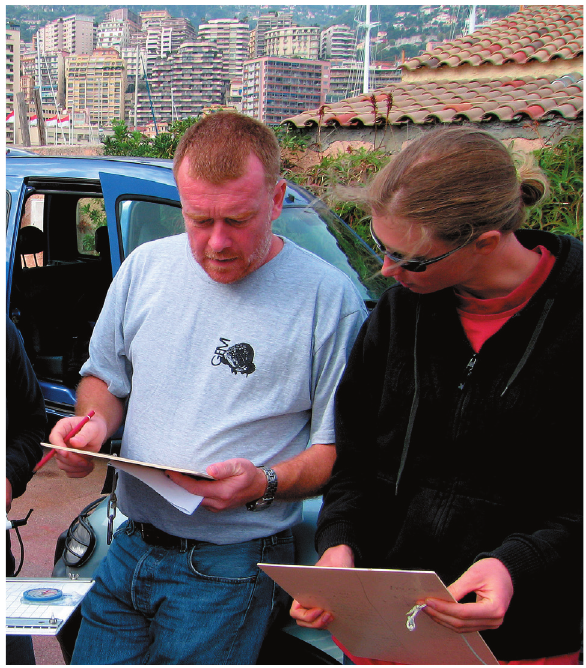
Fig. 2. Patrice Francour talking with a student before grouper monitoring carried by GEM in Monaco, in October 2006; © J.G.